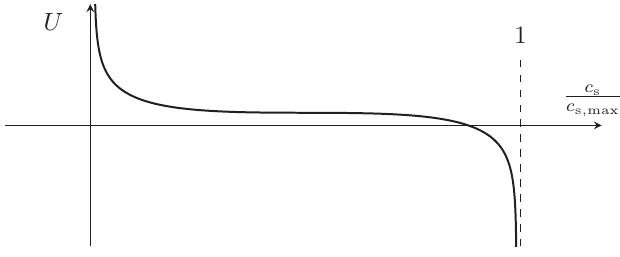
Figure 3: Possible representation of U